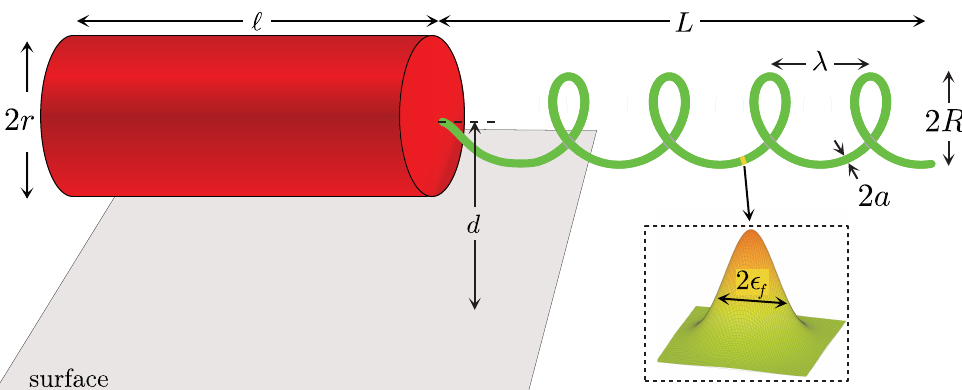
Figure 1. Schematic of our model bacterium located a distance d from a surface. The body of the bacterium was modeled as a cylinder with radius r and length (cid:96) . Each flagellum was modeled as a regular helix that tapers to zero radius at the point it attaches to the body with flagellar radius R , wavelength λ , axial length L , and filament radius a . Our simulations used a surface discretization of regularized Stokeslets to represent the cylinder and a string of regularized Stokeslets along the centerline of the flagellum. The inset represents a radially symmetric blob function described in Section 2.1.1 that is used to spread the force at a given point on the flagellar centerline. For the purpose of illustration, we show the blob function of two variables whose width is controlled by the regularization parameter (cid:101) f